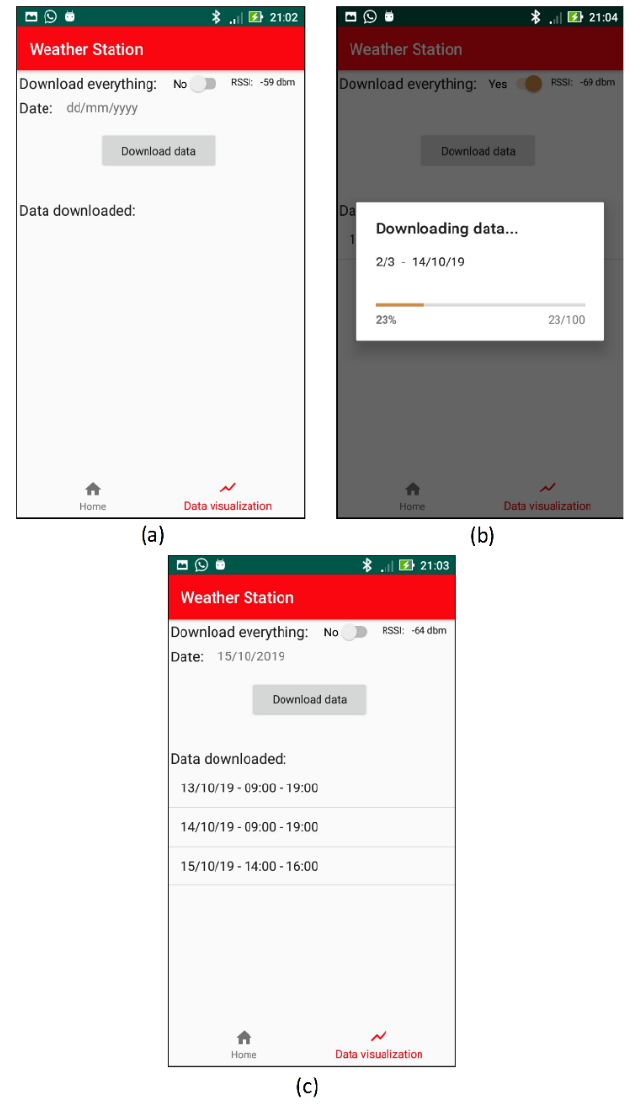
Table 2. Measured data transfer time and corresponding average throughput between the weather station and the Android